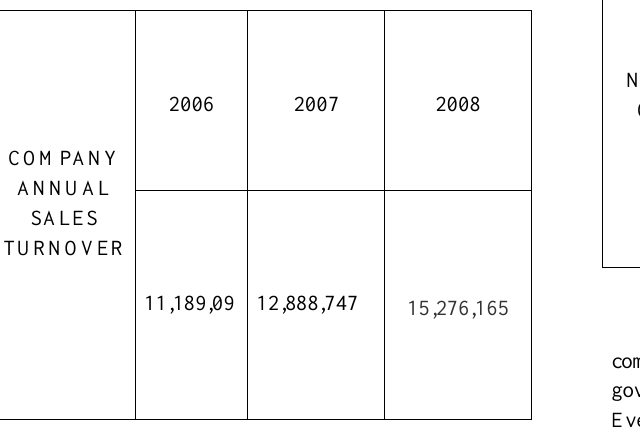
Table 3: Yearly Sales Turnover of XYZ (TL)